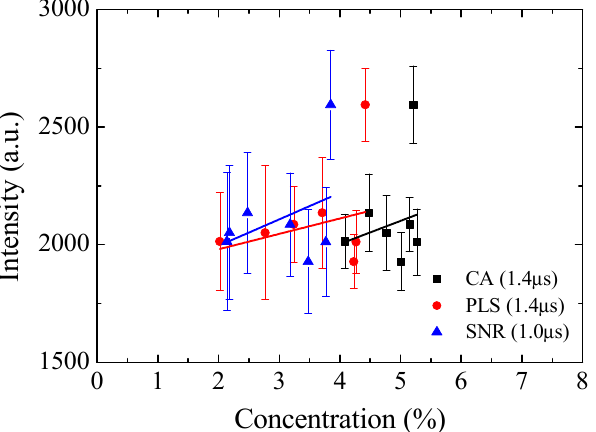
Figure 7. Correlation between the intensity and H concentration with maximum R 2 for CA, PLS, and SNR.